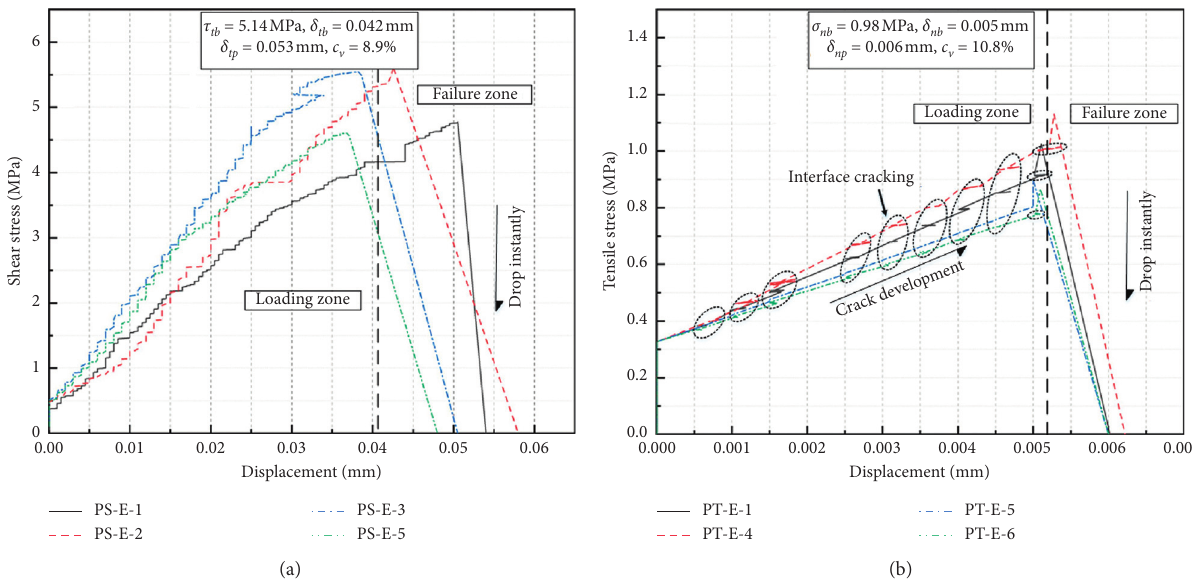
Figure 6: Stress-displacement curves of various specimens in direct shear test and tensile test. (a) The shear stress-displacement curve of specimen PS-E. (b).The tensile stress-displacement curve of specimen PT-E.